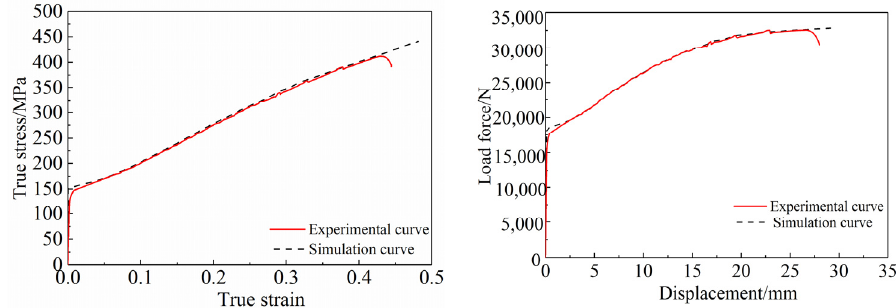
Figure 3. Contrast the simulated curves with experimental curves without considering the damage.